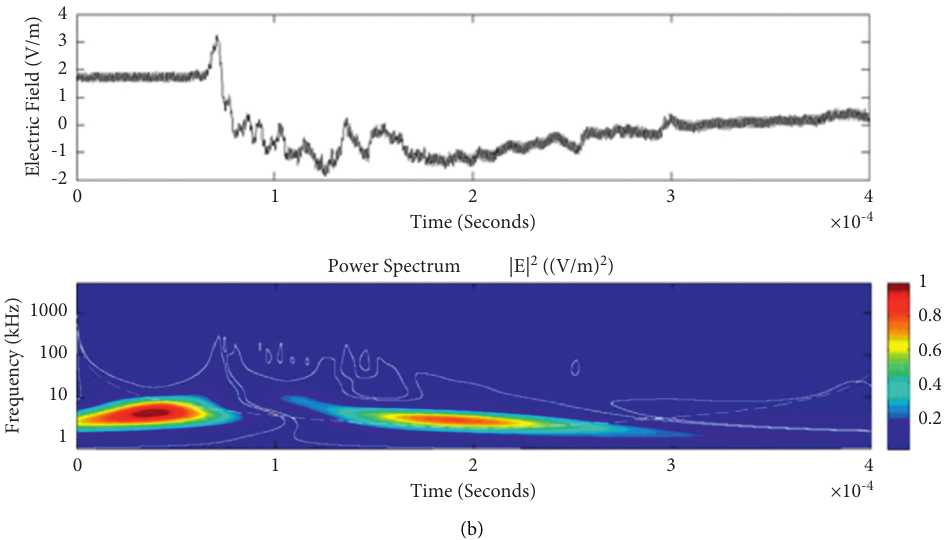
Figure 9: Example of the wavelet power spectrum of the first event (a) and second event (b) of the unusual lightning signal which is recorded as a flash number 20150416-0003 in Kathmandu, Nepal. The window size of the event is 400 μ